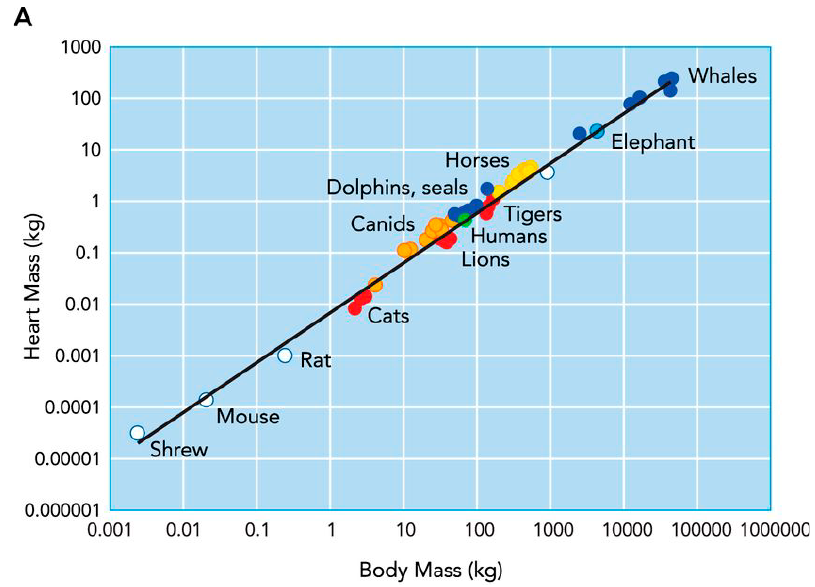
Figure 1. Relationship between heart mass and body mass across the mammalian species. Taken with permission from Williams et al., [1].